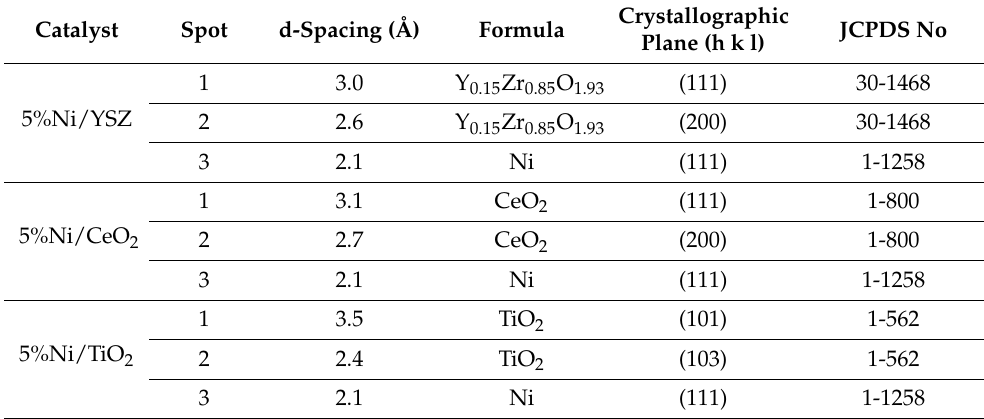
Table 2. Selected area electron diffraction (SAED) analysis of TEM images obtained for 5%Ni/YSZ, 5%Ni/CeO 2 and 5%Ni/TiO 2